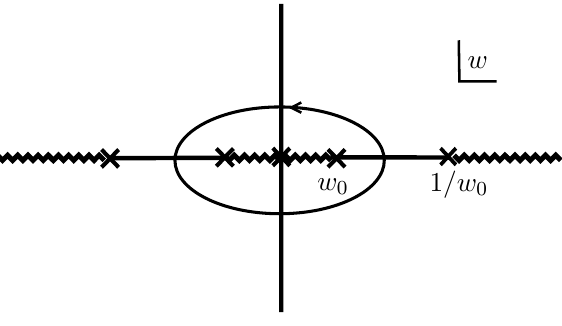
Figure 4 . Scattering amplitudes in the complex w -plane, where w = e i(cid:18) . Two copies of the t - channel appear on the right, related to each other by w ! 1 =w , and two copies of the u -channel cut appear on the